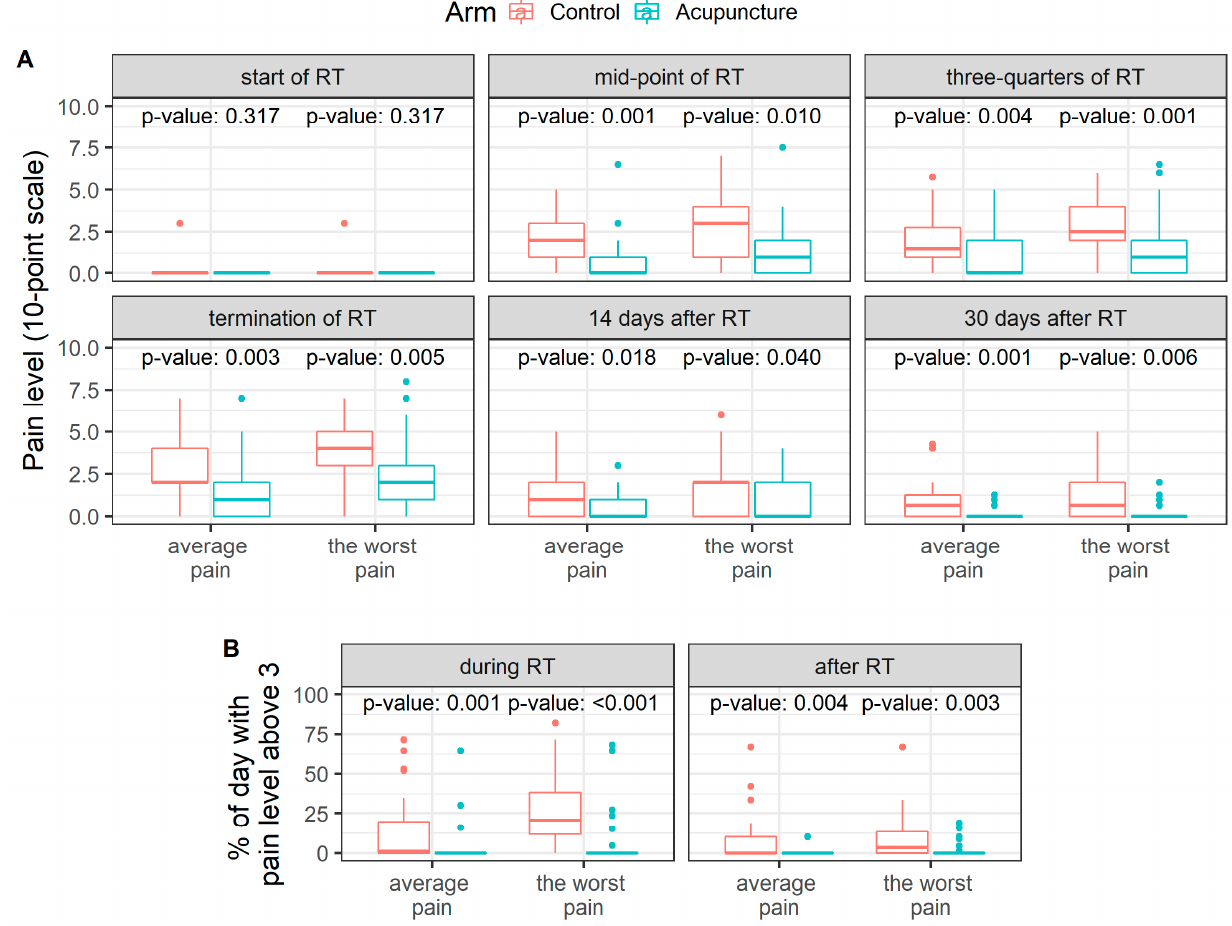
Figure 3. ( A ) Pain level in critical moments of treatment. ( B ) Percentage of days during radiotherapy and three months after radiotherapy when patients had pain level above three on a 10-grade scale.